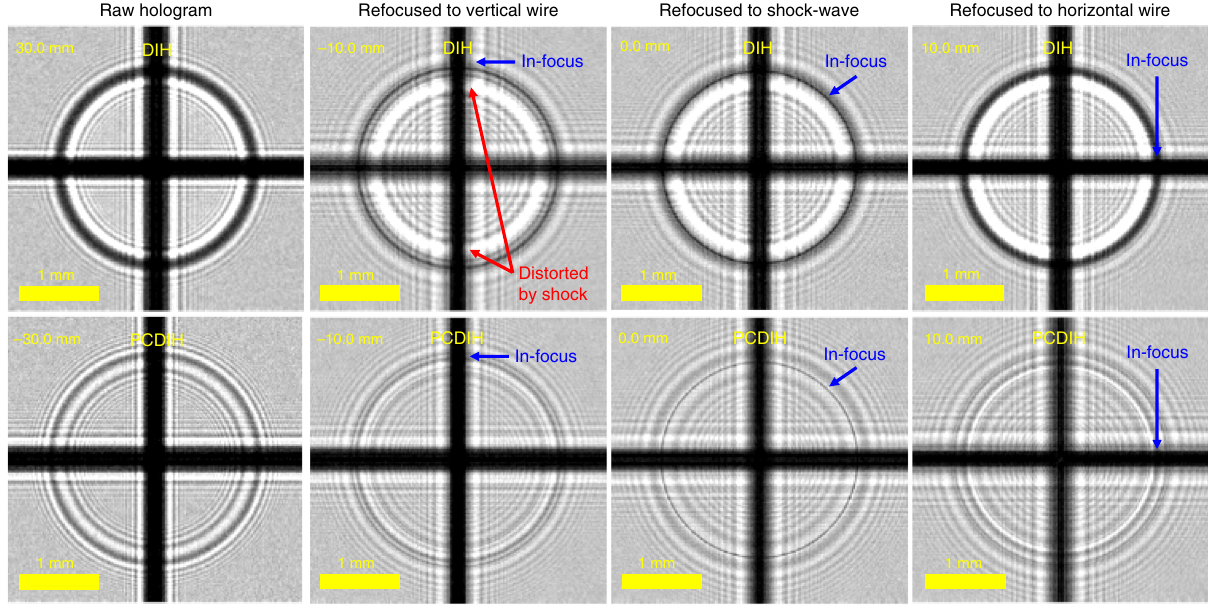
Fig. 7 DIH and PCDIH simulations of laser-spark plasma-generated shock-waves. These simulations show a vertical wire ( z = − 10 mm), shock-wave plane ( z = 0 mm), and horizontal wire ( z = 10 mm) captured from the DIH image plane ( z = 30 mm) and PCDIH image plane ( z = − 30 mm). The phase conjugate mirror is located at z = 510 mm. For this simulation, the spherical shock-wave has a constant shocked-gas density, shock-wave motion during laser light time-of- fl ight, and refraction effects. From left to right, the simulated raw recorded hologram, hologram refocused to the vertical wire, hologram refocused to the shock-wave edge, and hologram refocused to the horizontal wire are shown. This can be qualitatively compared with experimental results in Fig.